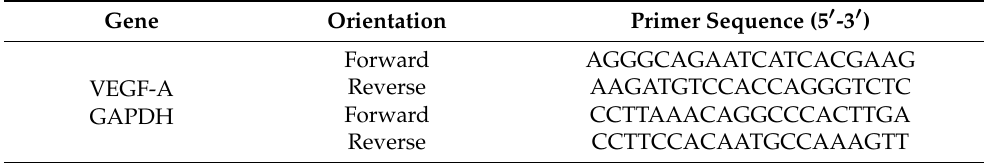
Table 1. Primer sequences used for semi-quantitative reverse transcription PCR. Gene Orientation Primer Sequence (5 (cid:48) -3 (cid:48) ) VEGF-A